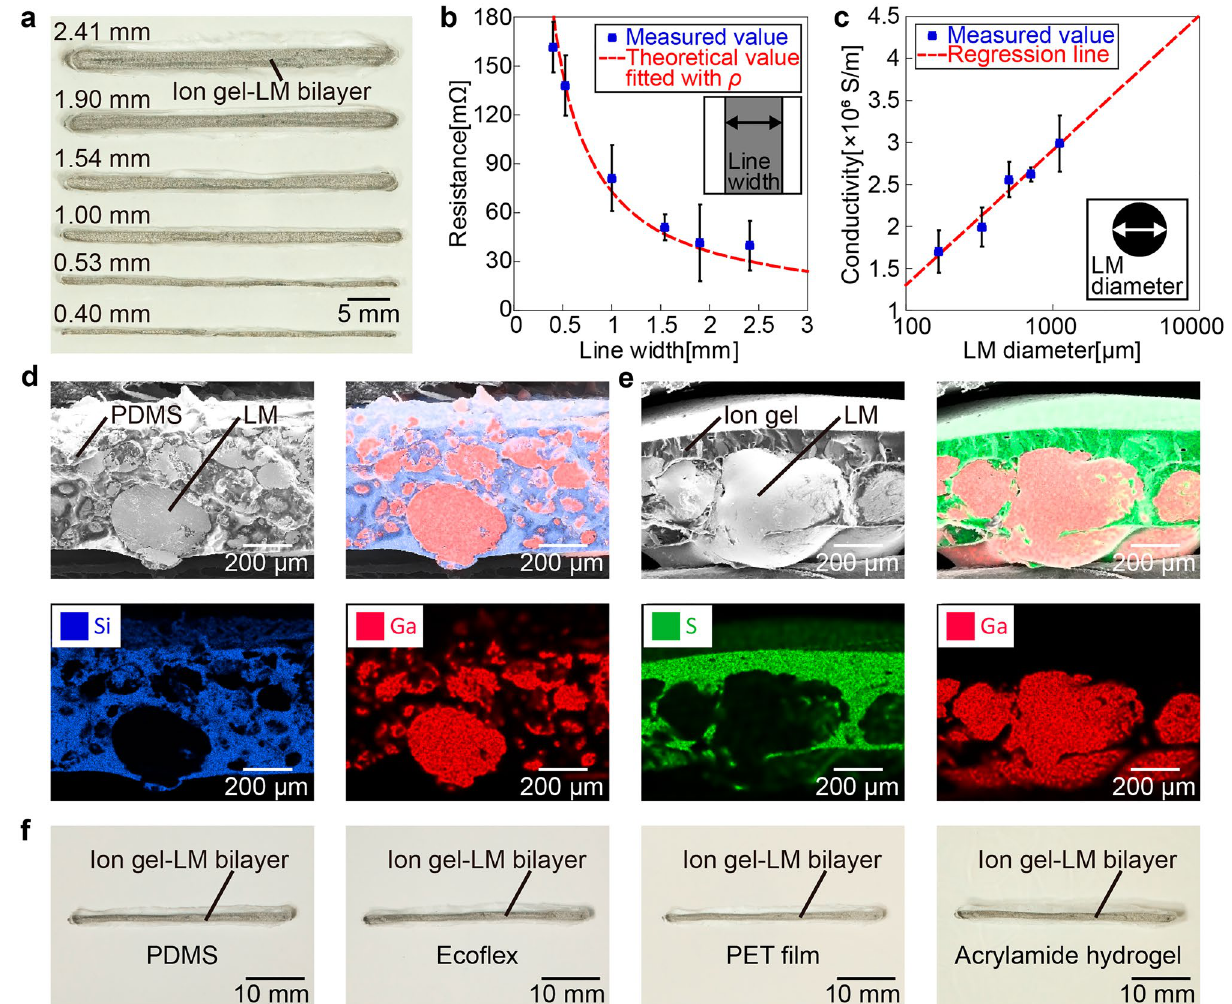
Figure 2. Fundamental characteristics of the ion gel–LM bilayer. ( a ) The ion gel–LM bilayer wirings with various linewidths. The minimum linewidth was 404 μm. ( b ) Relationship between linewidth and resistance value of the ion gel–LM bilayer wiring. The resistance value decreases as a function of the linewidth. ( c ) Relationship between LM particle diameter and resistance value of the ion gel–LM bilayer wiring. The resistance value decreases as a function of the LM particle diameter. ( d ) Cross-sectional images of PDMS–LM composite using scanning electron microscopy-energy dispersive X-ray spectroscopy (SEM EDX). ( e ) Cross-sectional images of the ion gel–LM bilayer using SEM EDX. ( f ) The ion gel–LM bilayer wirings on PDMS, Ecoflex, PET film, and acrylamide hydrogel. The ion gel–LM bilayer wiring can be applied to various flexible at a thickness of 82.7 μm. This indicates that the ion gel layer did not function as an insulative layer at a thick- ness of 82.7 μm due to mechanical instability of the used ion gel. Furthermore, the ion gel–LM bilayer wiring became extremely fragile and difficult to fabricate when the thickness of the ion gel insulating layer was less than 82.7 μm. The correlation coefficient between the thickness and resistance of the ion gel insulating layer is 0.987. Figure 2c shows the relationship between the particle diameter of the LM when casting the solution and con- ductivity. As shown in Fig. 2c, smaller LM particle sizes result in lower conductivity. In addition, the graph with the logarithm of the LM particle diameter as the abscissa shows that the conductivity and LM particle diameter have a linear relationship with a correlation coefficient of 0.949. Figure 2d and e show the results of the SEM EDX analysis of the cross-sections of the flexible materials comprising LM mixed with PDMS (PDMS–LM composite) and LM mixed with ion gel (ion gel–LM bilayer). In both cases, the LM particle diameter during casting was adjusted to approximately 150–200 µm. Figure 2d shows that in the case of the PDMS–LM composite, the LM mixed with PDMS is relatively evenly dispersed in PDMS, the PDMS walls that separate the LM particles are thick, and a PDMS film is formed on the bottom surface. In contrast, Fig. 2e shows that in the case of the ion gel–LM bilayer, the LM mixed with the ion gel is concentrated at the bottom to form particles with large diam- eters, the ion gel walls that separate the particles are thin, and the LM is exposed from the bottom surface. The LM deposited and exposed at the bottom serves as the conductive layer and the thick ion gel remaining at the top serves as the insulative layer. Figure 2e shows that the thickness of the ion gel–LM bilayer is approximately